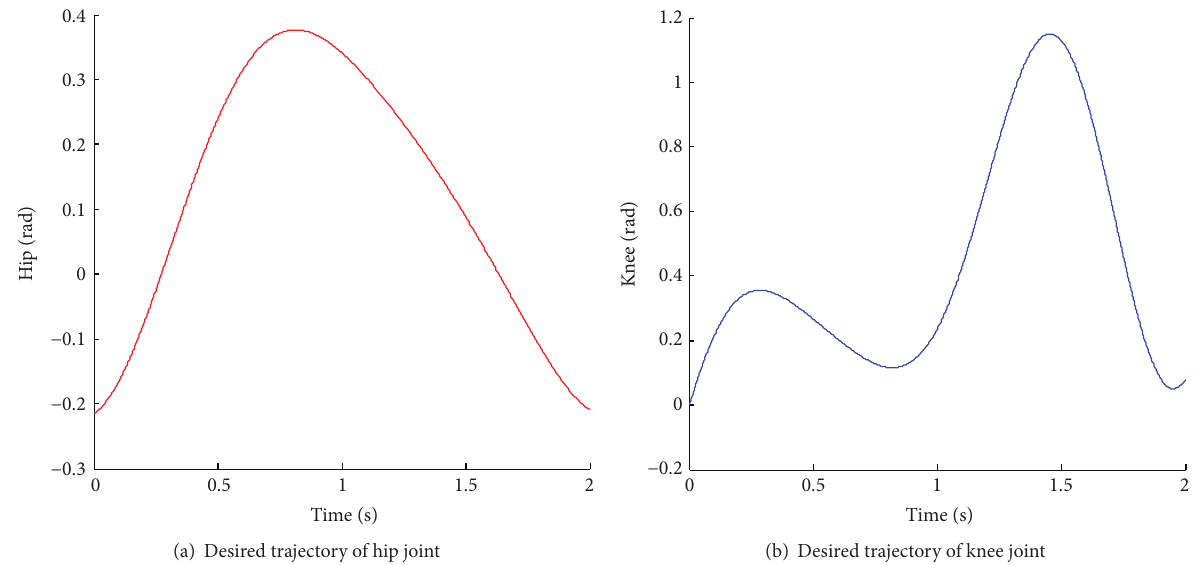
Figure 5: The desired joint trajectory of human lower limb movement. The initial posture is in the vertical